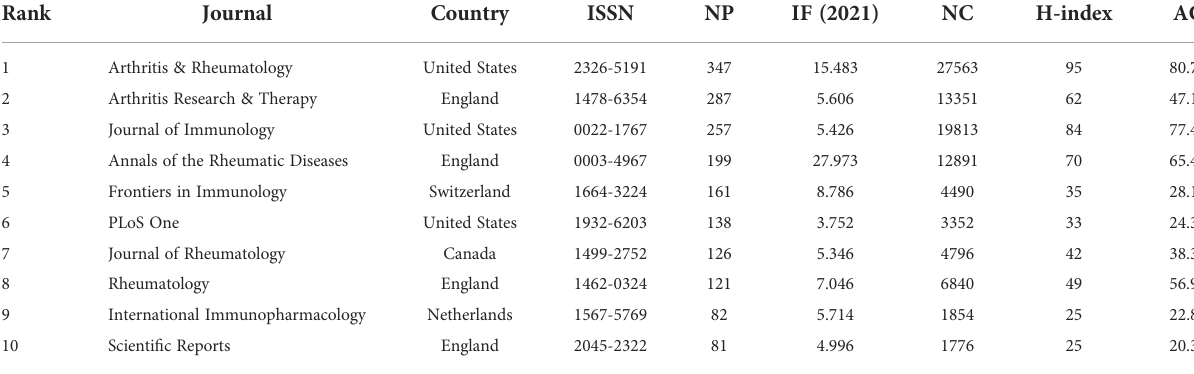
TABLE 5 The top 10 most productive